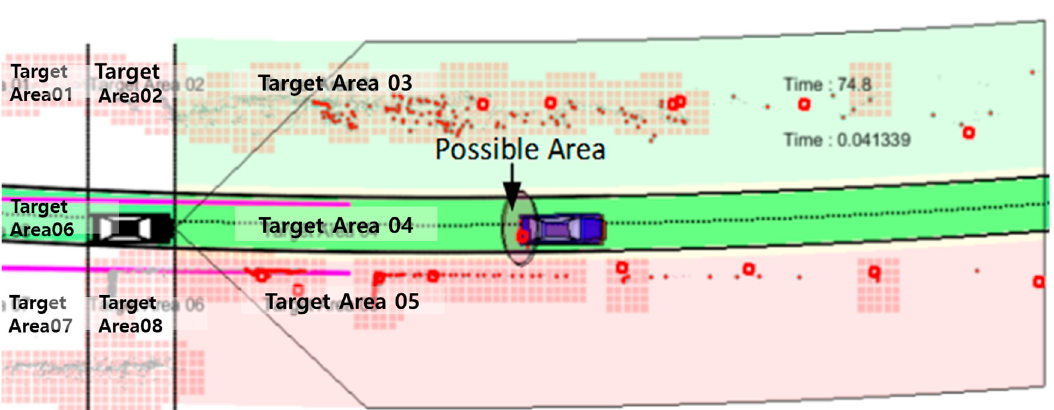
Figure 6. Possible area represented on the body-fixed coordinate.